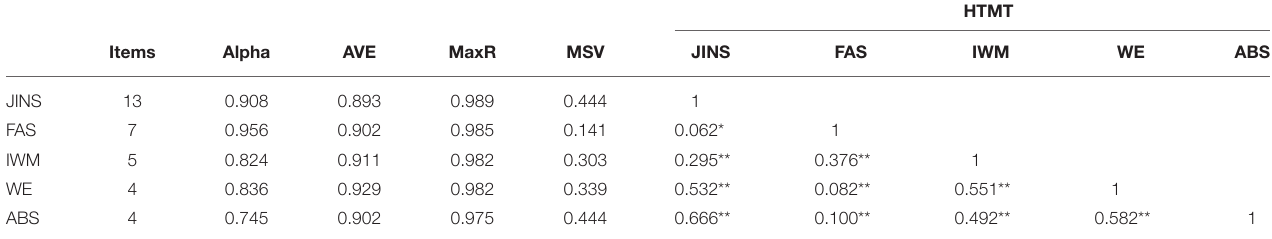
TABLE 1 | Construct reliability and validity.